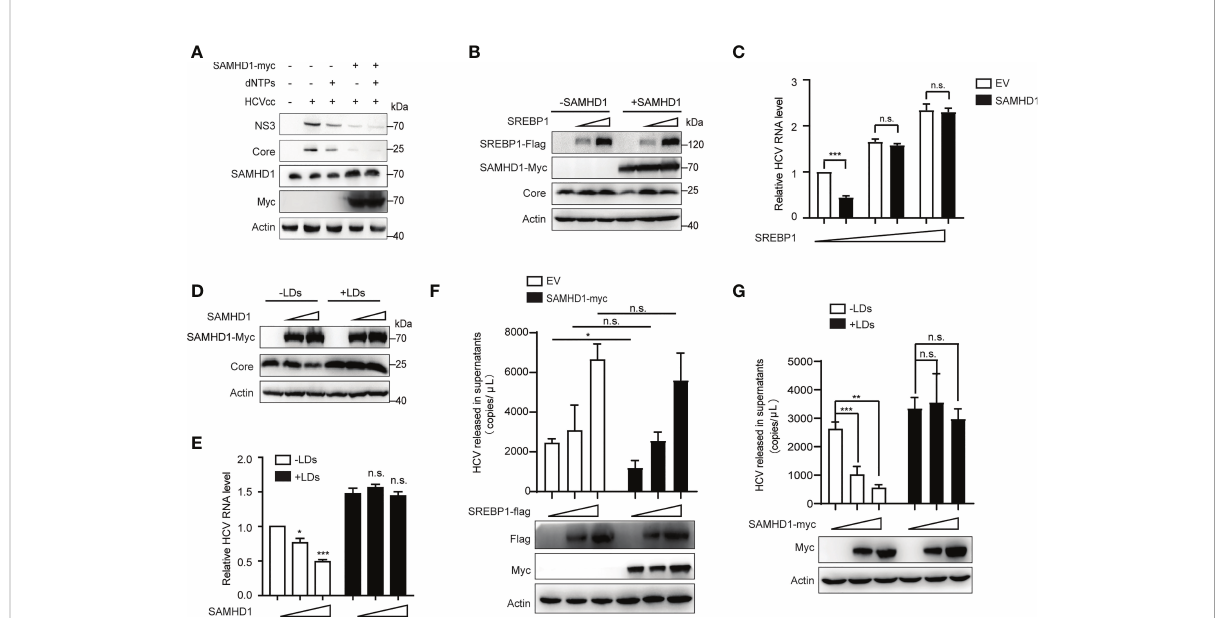
FIGURE 7 Supplementary lipid rescues HCV replication inhibited by SAMHD1. (A) pSAMHD1-myc or pcDNA4.0 was transfected into Huh7 replicon cells with or without the addition of 10 m M dNTPs and cultured for 48 h. Expression levels of HCV core and NS3 proteins were determined by Western blotting ( n = 3). (B) Plasmids encoding SREBP1- fl ag were co-transfected with pSAMHD1-myc into Huh7.5.1 cells and followed by infection with JFH1 HCVcc (MOI = 0.2) for an additional 72 h. Expression of HCV core protein detected by Western blotting was used to evaluate the HCV replication level. (C) HCV RNA in cells was isolated for qRT-PCR analysis. Cells in the control group were transfected with the same amount of empty vector. Values of qRT-PCR are shown as means ± SD ( n = 3) and the value of the control group is set to 1. (D) Huh7.5.1 cells were transfected with pSAMHD1-myc followed by infection with JFH1 HCVcc (MOI = 0.2) in the presence of 100 m g/ml LDs for an additional 72 h. Expression of HCV core protein in cells detected by Western blotting was used to measure HCV infection level. (E) HCV RNA in cells was extracted for qRT-PCR analysis. Data are representative of three independent experiments and shown as means ± SD. (F) Plasmids encoding SREBP1- fl ag were transfected into SAMHD1-KO Huh7.5.1 cells with or without extrogenous SAMHD1 expression and followed by infection with JFH1 HCVcc (MOI = 0.2) for an additional 72 h. HCV RNA in culture medium was isolated for qRT-PCR analysis. Values of qRT- PCR are shown as means ± SD ( n = 3). Expression of extrogenous proteins was detected by Western blotting. (G) SAMHD1-KO Huh7.5.1